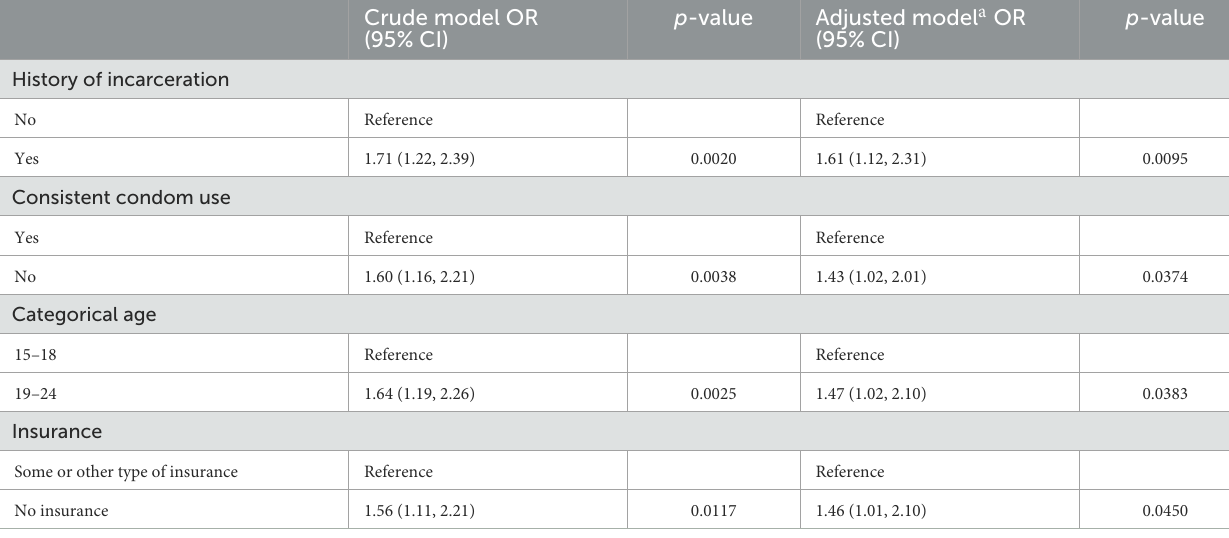
TABLE 4 Crude and adjusted associations for chlamydia outcomes and history of incarceration from primary complete case analysis.